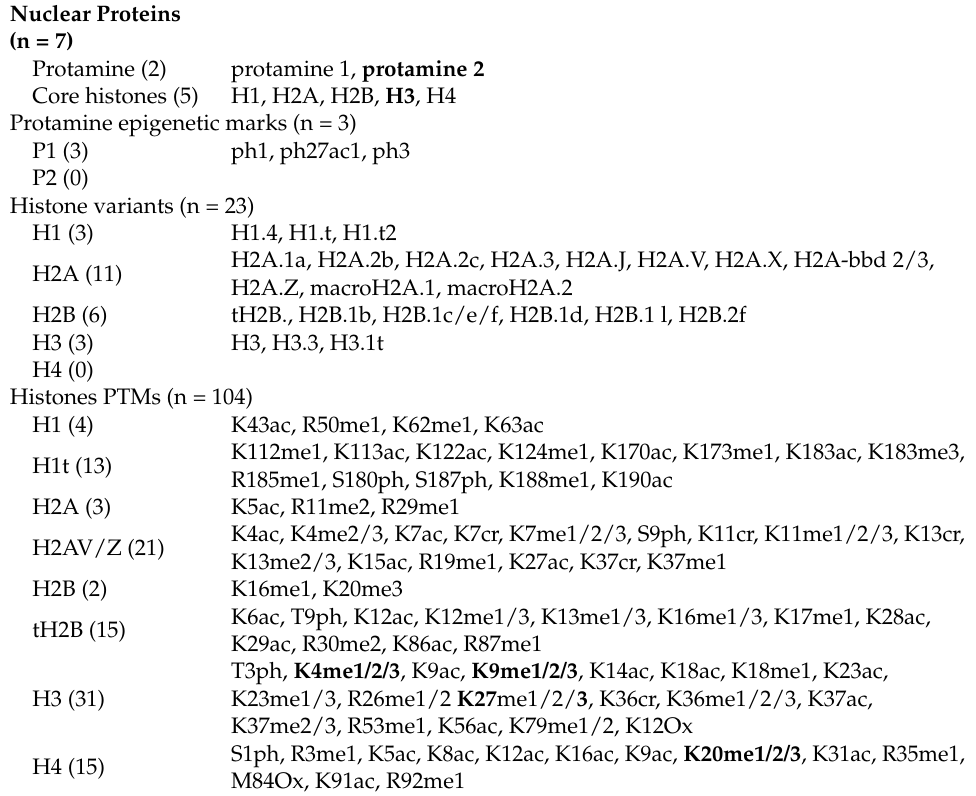
Table 2. Nuclear proteins and epigenetics marks of histones described in human spermatozoa (n =